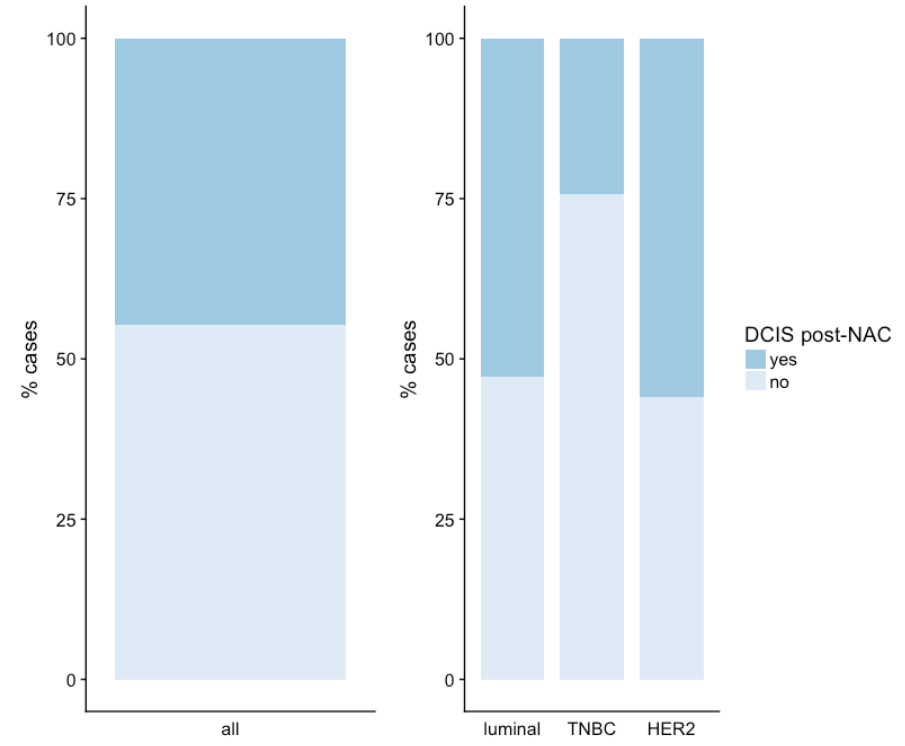
Figure 2. Presence of a DCIS component in post-NAC breast cancer surgical specimens.